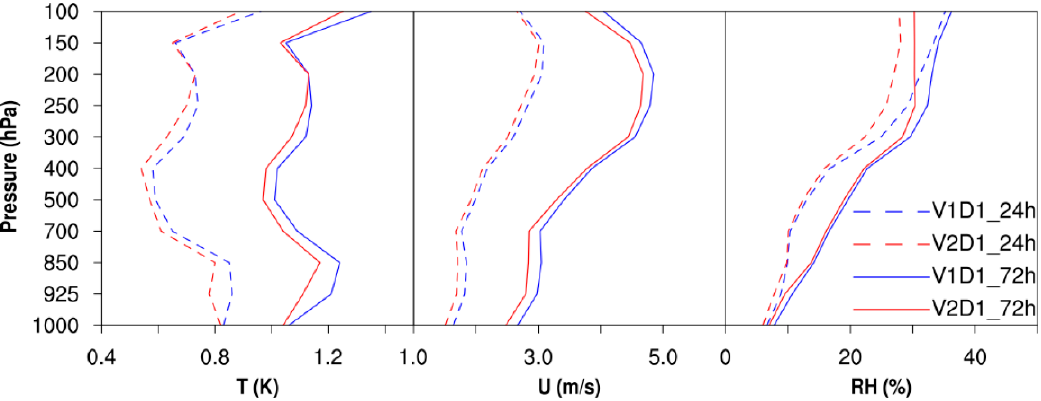
Figure 6. Vertical profile of the RMSE of temperature (T), U-component wind (U), and the relative humidity (RH) at the 24-h (dashed lines), and 72-h (solid lines) forecasts in V1D1 (blue lines) and V2D1 (red lines), verified against NCEP analysis. Composites were made for 2016 and 2018.